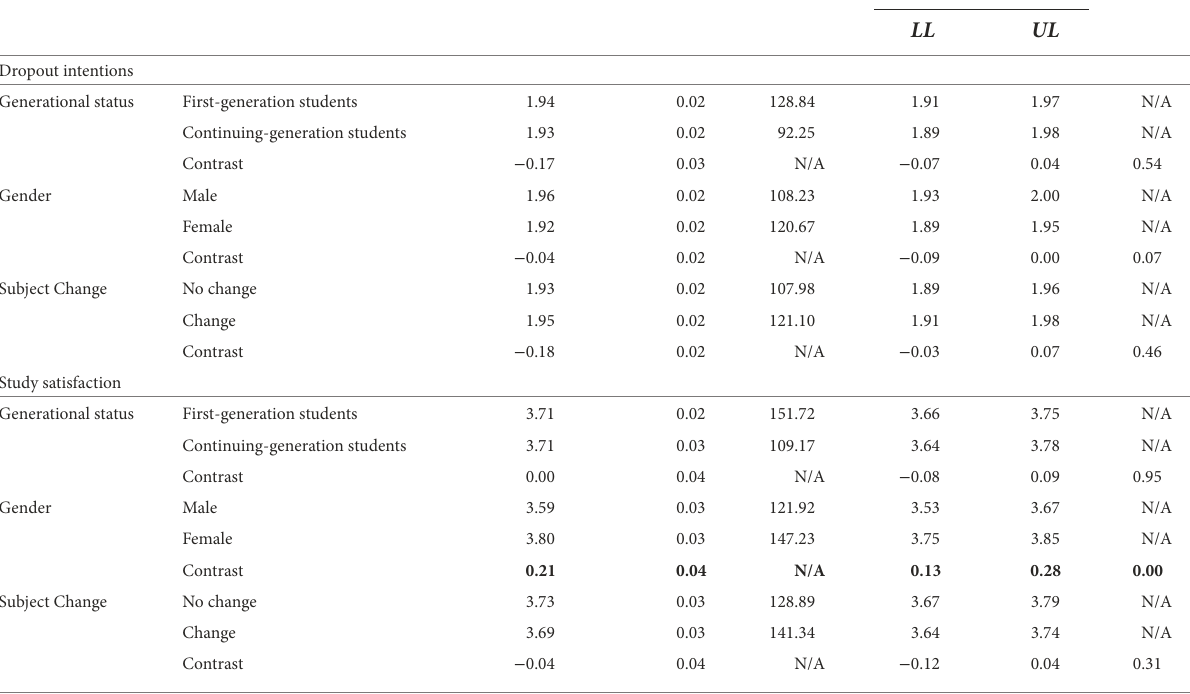
TABLE 7 Marginal means for dropout intentions and study satisfaction predicted by gender, generational status, and subject change (SES controlled). Aspiration